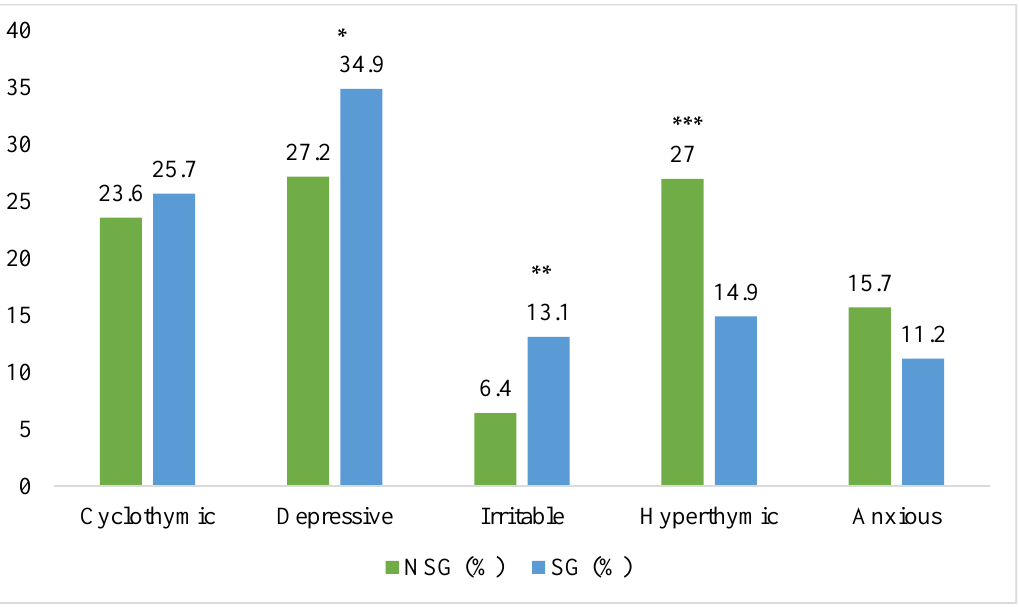
Figure 2. Distribution of suicide ideation lifetime among affective temperaments. * p < 0.05; ** p < 0.01; *** p < 0.001; NSG: non suicidal group; SG: suicidal